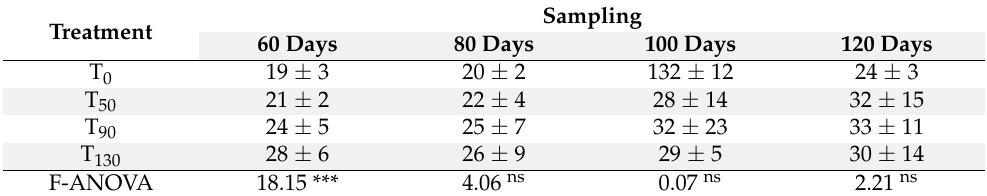
Table 4. Sodium content (mg/L) in leachates. Entries represent means ± standard errors from n = 3